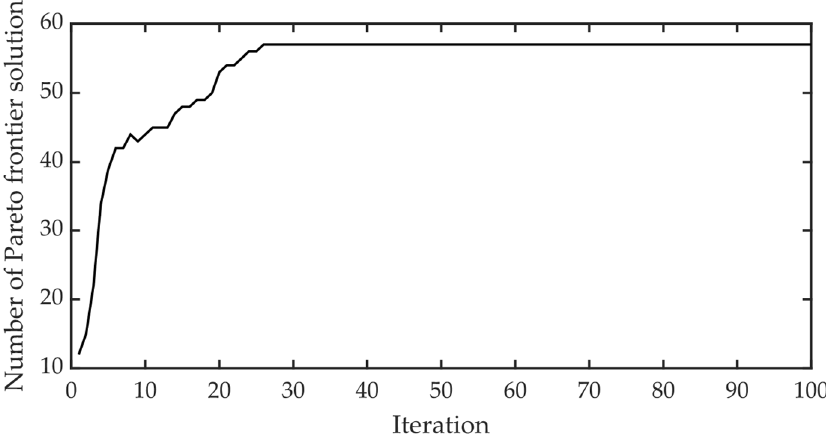
Figure 4. Changes in the number of Pareto frontier solutions.